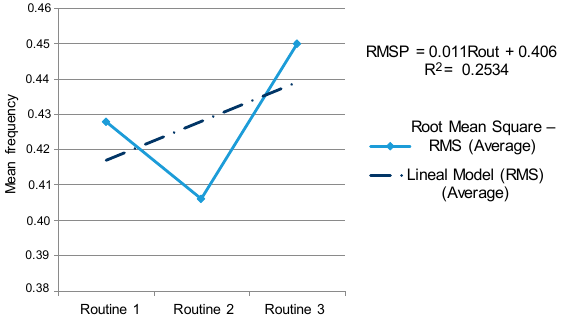
Figure 10. Progress between routines of the mean frequency of player 2 in the vastus lateralis.